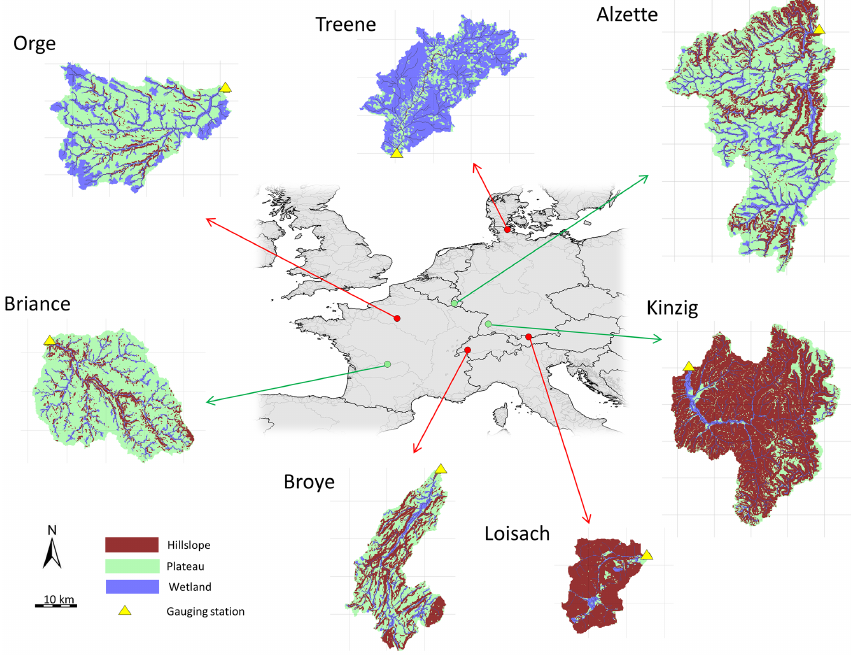
Figure 1. The locations of the seven study catchments and their respective landscape classes according to HAND and local slope. Catchments represented by red and green symbols in the context map indicate donor and receiver catchments, respectively, for the transferability analysis. Displayed grids correspond to the modelling grids used in mHM